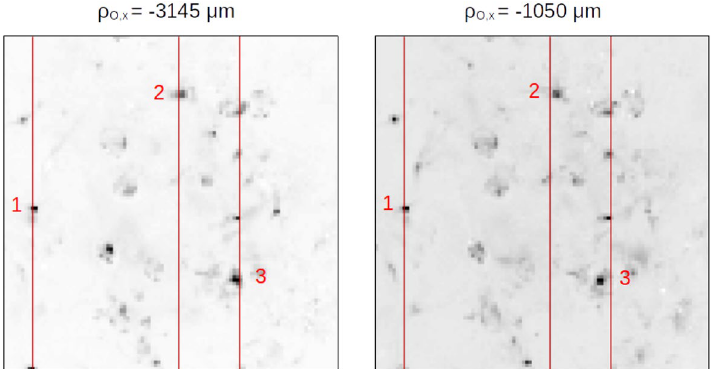
Figure 5. Change of perspective within the 1 mm 3 sample of starch grains suspended in gel, as obtained through CLM. The change of perspective is implemented by correlating the intensity registered by each pixel of the spatial sensor ( D a ) with the intensity registered by a small portion ( 10 × 10 pixels) of the angular sensors ( D b ), centered on the point ρ b = ( − M ρ O , x , 0 ) , corresponding to the horizontal coordinate ρ O , x on the objective lens [i.e., by varying the second argument in Eq. (2)]. Two different viewpoints of the sample are shown, selected on the horizontal diameter of the objective lens. The image on the left is the perspective from a point placed ◦ 3145 µ m to the left of the center of the lens, corresponding to an angle of − 5 from the optical axis (OA). The ◦ one on the right is the viewpoint at − 1050 µ m ( − 2 with respect to OA). Three different features are highlighted. The starch granule labeled by 1 does not shift with a change of viewpoint, meaning it is placed on the focal plane of the objective. The granule labeled with 2 shifts to the right as the viewpoint shifts to the right, meaning it is placed (out of focus) on a plane between the lens and its focal plane. The granule labeled with 3, on the other hand, suffers a shift in the opposite direction, meaning its longitudinal distance from the lens is larger than the focal length. As one would expect from a viewpoint change along the horizontal, none of the visible granules change their position along the vertical